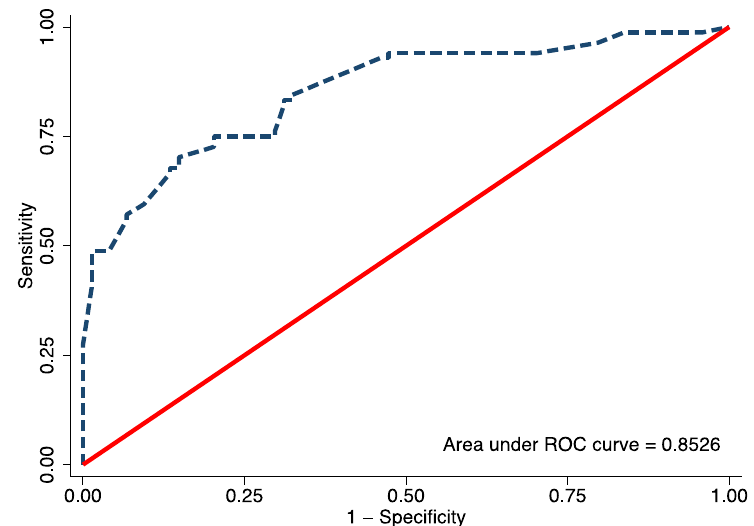
Figure 1. The area under the receiver operating characteristic (ROC) of the final proposed diagnostic model, including age, body mass index, metaphyseal-diaphyseal angle, and medial metaphyseal beak angle.